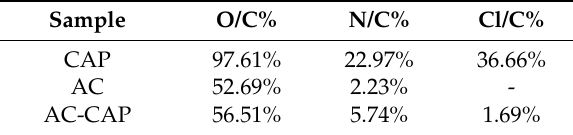
Table 7. The atomic ratio of the samples.